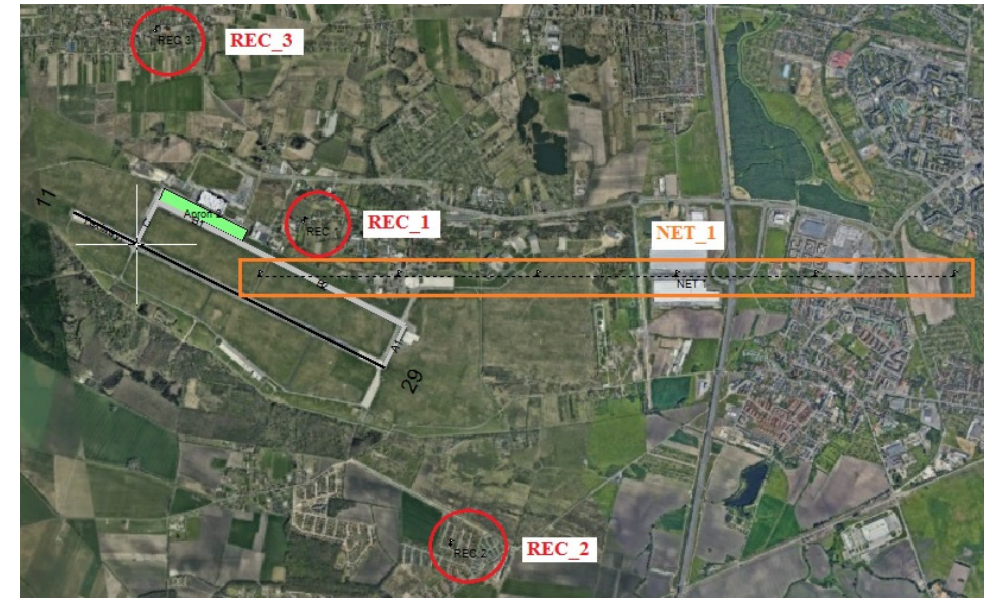
Figure 1. Receptor